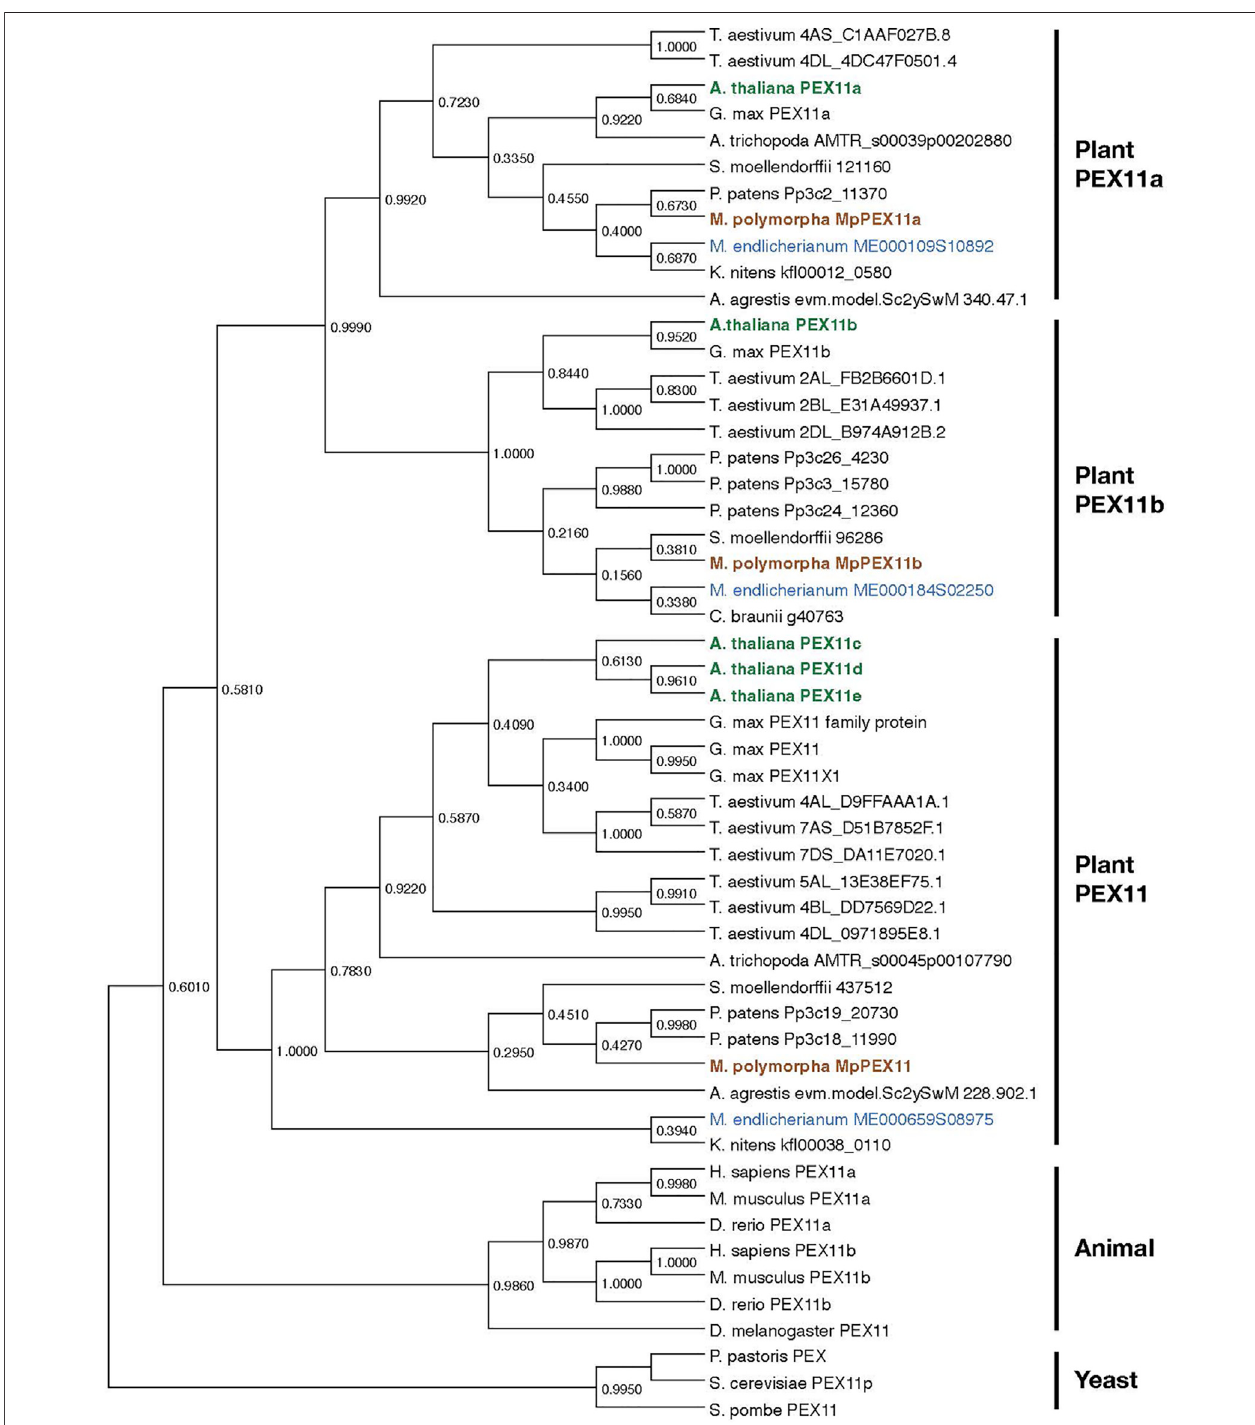
FIGURE 6 | Phylogenetic relationships of PEX11 subfamilies. The numbers are the proportion of trees in which the associated sequences cluster together. Sequences of A. thaliana , M. polymorpha , and M. endlicherianum are colored as representatives from among angiosperms, bryophytes, and algae, respectively. The phylogenetic tree for PEX11 homologs was inferred using the Maximum Likelihood method and JTT matrix-based model (Jones et al., 1992) with MEGA11 (Stecher et al.,2020; Tamura et al., 2021).All positionswithless than 95%site coverage wereeliminated,i.e., fewer than5%alignment gaps, missingdata,and ambiguous bases were allowed at any position (partial deletion option). Orthologue sequences in plants were obtained from the datasets for C. braunii (Nishiyama et al., 2018), M. endlicherianum (Cheng et al., 2019), K. nitens (Hori et al., 2014), M. polymorpha (Montgomery et al., 2020), P. patens (Lang et al., 2018), A. agrestis (Li et al., 2020), S. moellendorf fi i (Banks et al., 2011), A. trichopoda (Amborella Genome Project, 2013), A. thaliana (Berardini et al., 2015), G. max (Schmutz et al., 2010), and T. aestivum